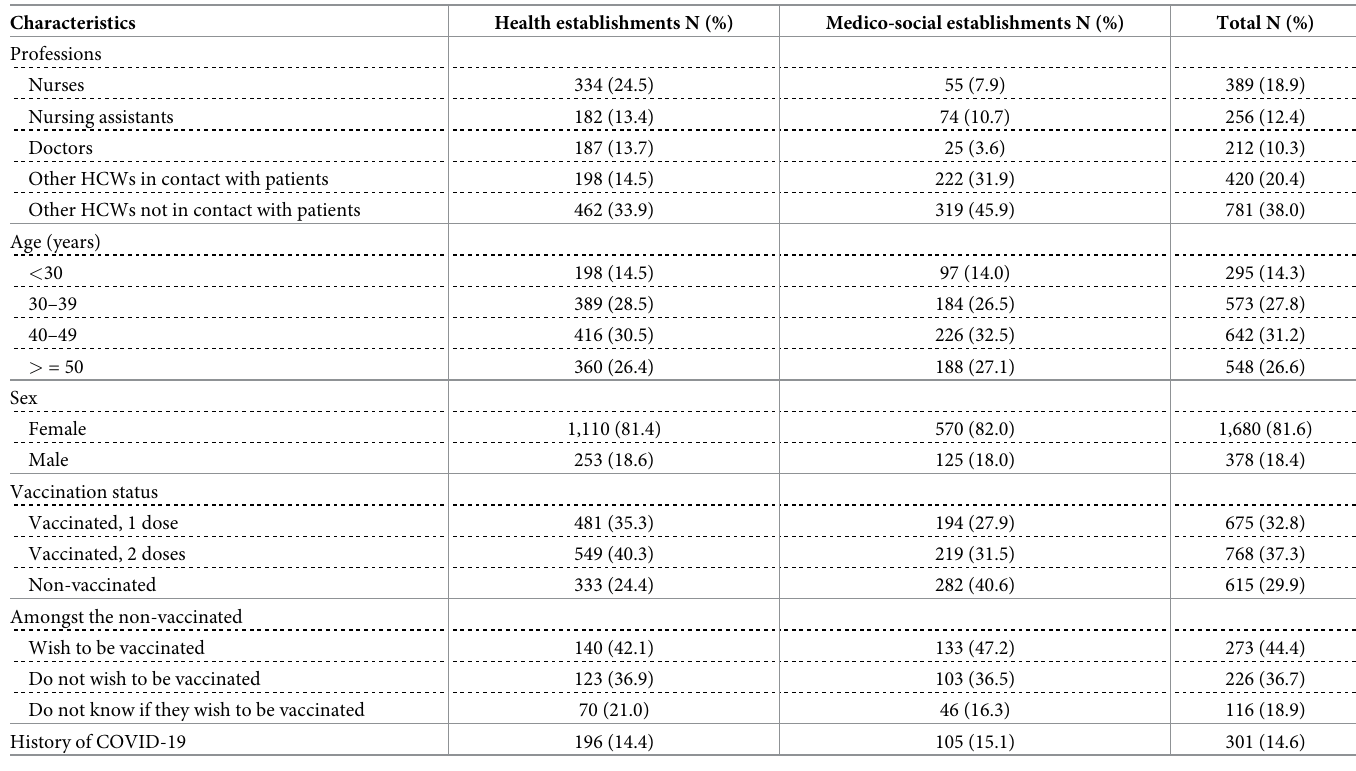
Table 1. Participants’ characteristics, globally, and by sector of